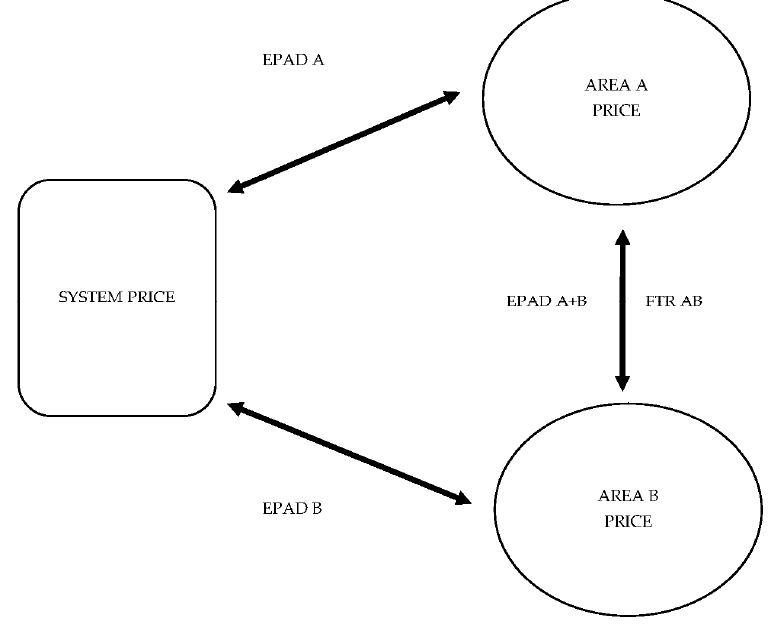
Figure 1. Structural differences with regards to the underlying of the three